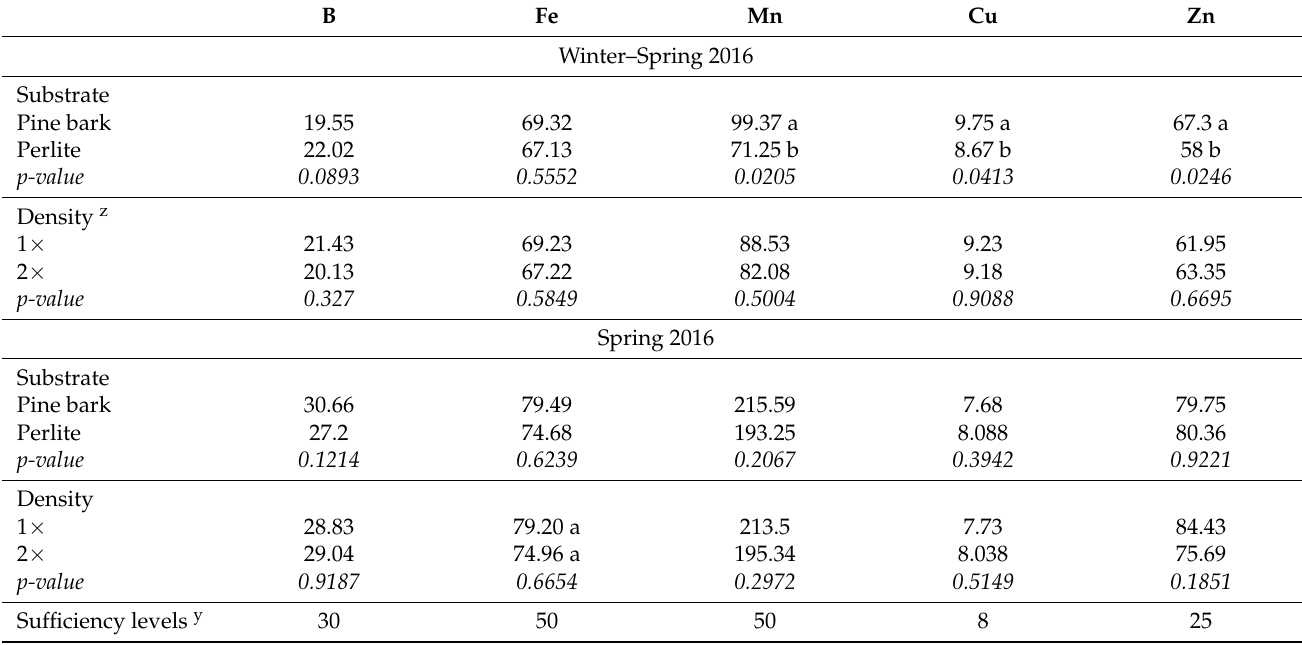
Table 4. Effect of substrate and planting density on foliar micronutrient concentration (mg kg − 1 dry mass) of ‘Socrates’ cucumber in two trials in